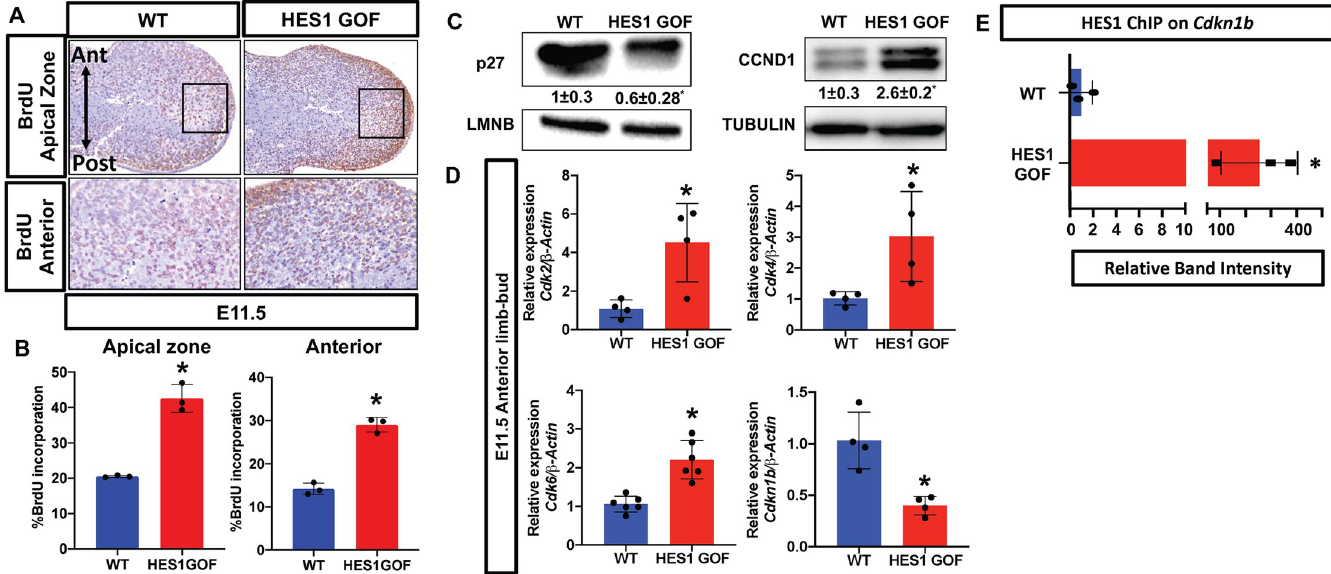
Fig 2. Hes1 over-expression within limb bud mesenchyme promotes cell proliferation. (A) BrdU labeling of WT and HES1 GOF limb buds at E11.5 (N = 3) (B) Quantification of BrdU positive cells within the apical zone and anterior domain (N = 3). Asterisks indicate significance with a p-value < 0.05 (Student’s t-test). (C) Western blots of p27 and CCND1 utilizing protein isolated from E11.5 WT and HES1 GOF limb buds. LMNB and TUBULIN are loading controls. Quantification represented as fold change ± SD relative to WT N = 3. (D) qPCR for Cdk2 , Cdk4 , Cdk6 and Cdkn1b using RNA isolated from the anterior halves of WT and HES1 GOF limb buds at E11.5 (N � 4). Each data point represents separate animals. Asterisks indicate significance with a p-value < 0.05 (Student’s t-test). (E) Densitometry measurements of ChIP PCR amplifications from the chromatin containing an E-Box within the Cdkn1b promoter of WT and HES1 GOF limb buds (N = 3; p- value < 0.05; Student’s